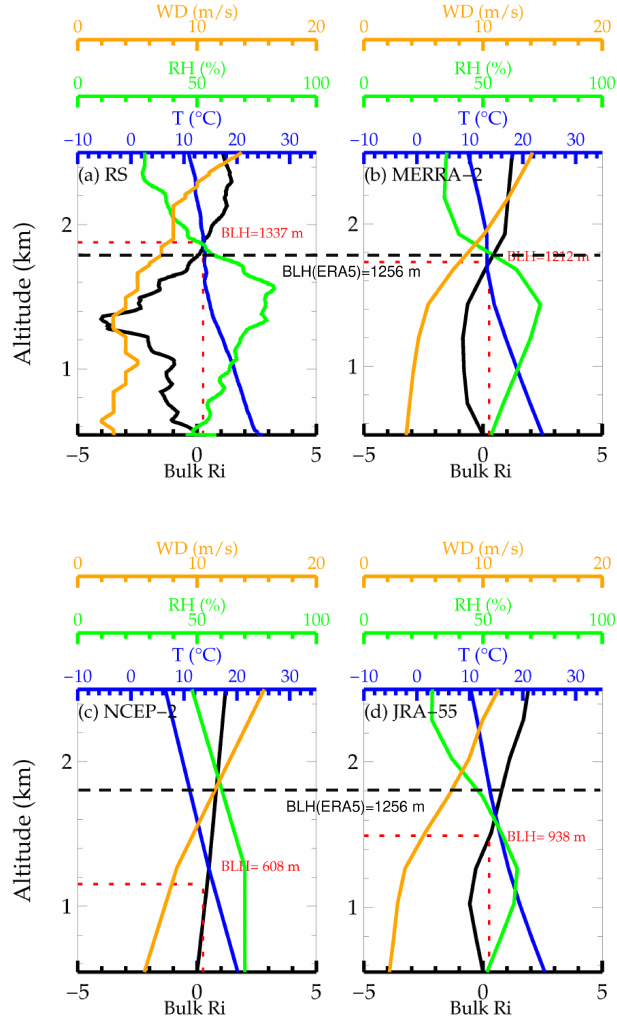
Figure 1. Profiles of basic atmospheric parameters from the ground up to 2.5kma.g.l., including wind speed (orange), bulk Ri (black), temperature (blue), and RH (green) at 06:00UTC (14:00LST) on 6 June 2016 at Chongqing (29.6 ◦ N, 106.4 ◦ E; 541m) from ra- diosonde (a) , MERRA-2 (b) , NCEP-2 (c) , and JRA-55 (d) reanal- ysis datasets. The boundary layer height (BLH) in each subplot is marked as dashed red lines and red text, and the BLH for ERA5 is 1265m in this case (dashed black